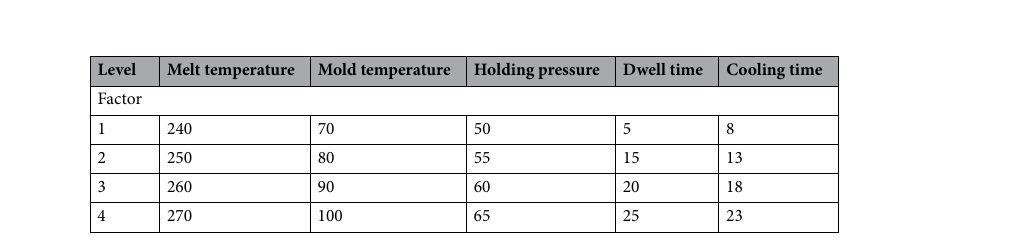
Table 2. Four-level five-factor orthogonal experiment